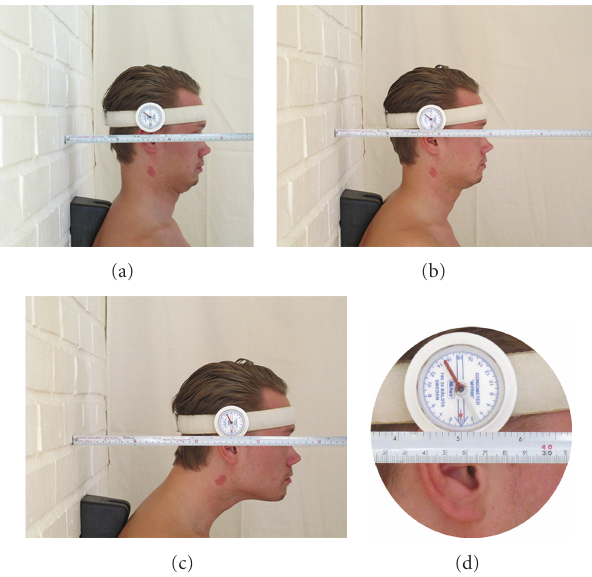
Figure 1: Measuring in the retracted, neutral, and protracted position of the head with the inclinometer and metal tape